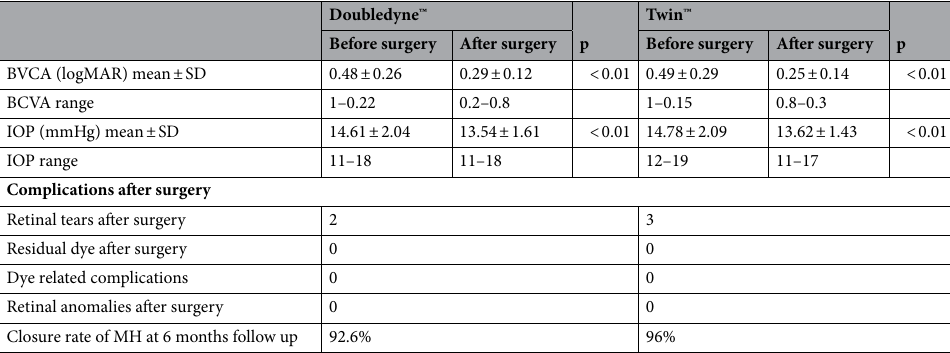
Table 3. Differences in best correct visual acuity (BCVA), measured as logMAR, and in intraocular pressure (IOP) before and after surgery (6 months follow up) in two DoubledyneTM and TwinTM groups and significance values (p); number of complications after surgery in both groups.